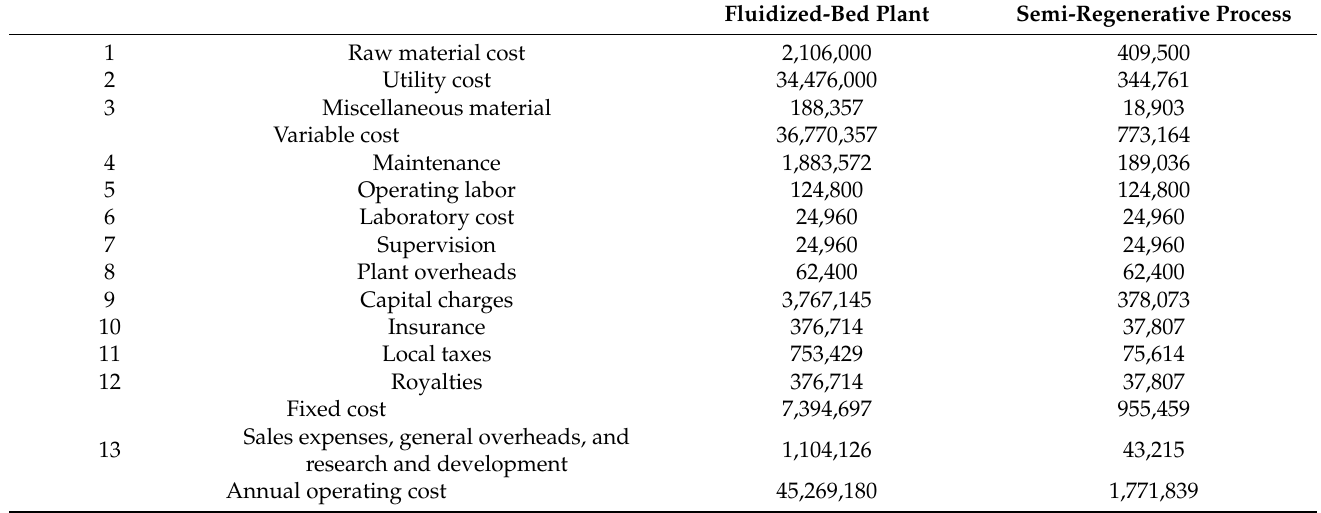
Table 9. Annual operating